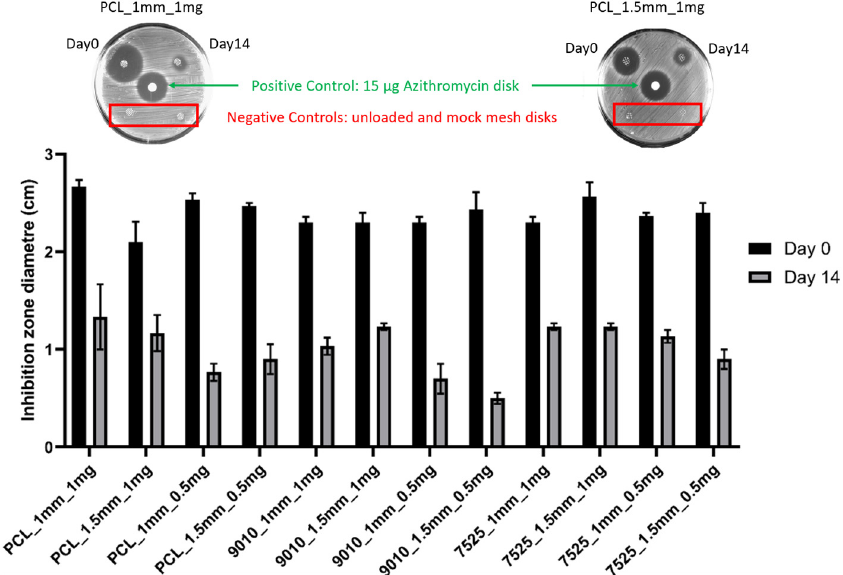
Figure 5. Inhibition zone measurements for day 0 and day 14 for all testing groups ( bottom ). A representative image is shown of the testing plates ( top ), where clear inhibition zones can be seen for the fabricated meshes at day 0 and day 14 and for the positive control, whereas the mock loaded and unloaded negative controls did not exhibit the inhibition